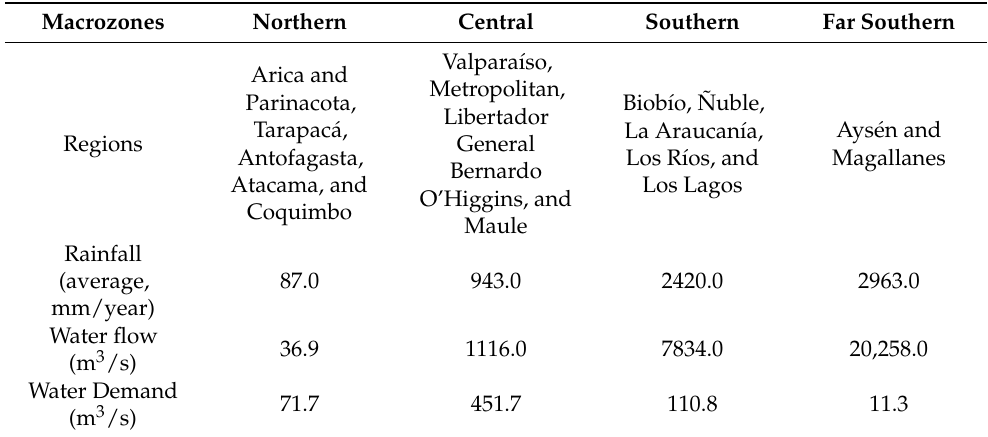
Ays é n and Magallanes